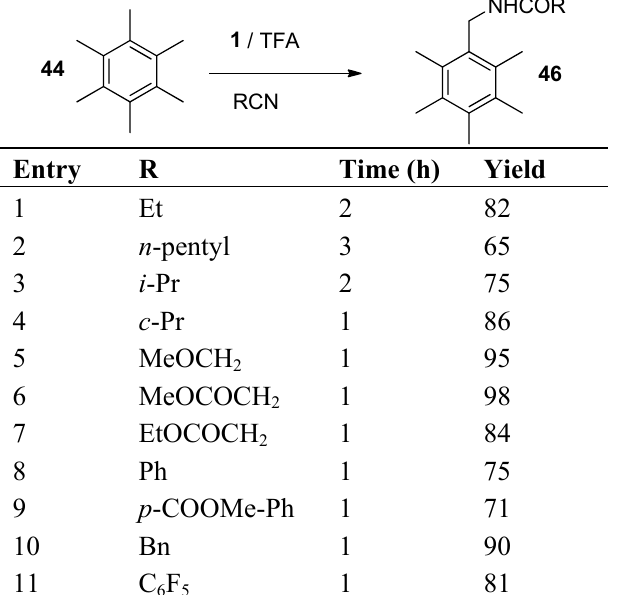
Table 4. Ritter-type functionalization of the benzylic position in hexamethylbenzene mediated by F-TEDA-BF [44]. 4